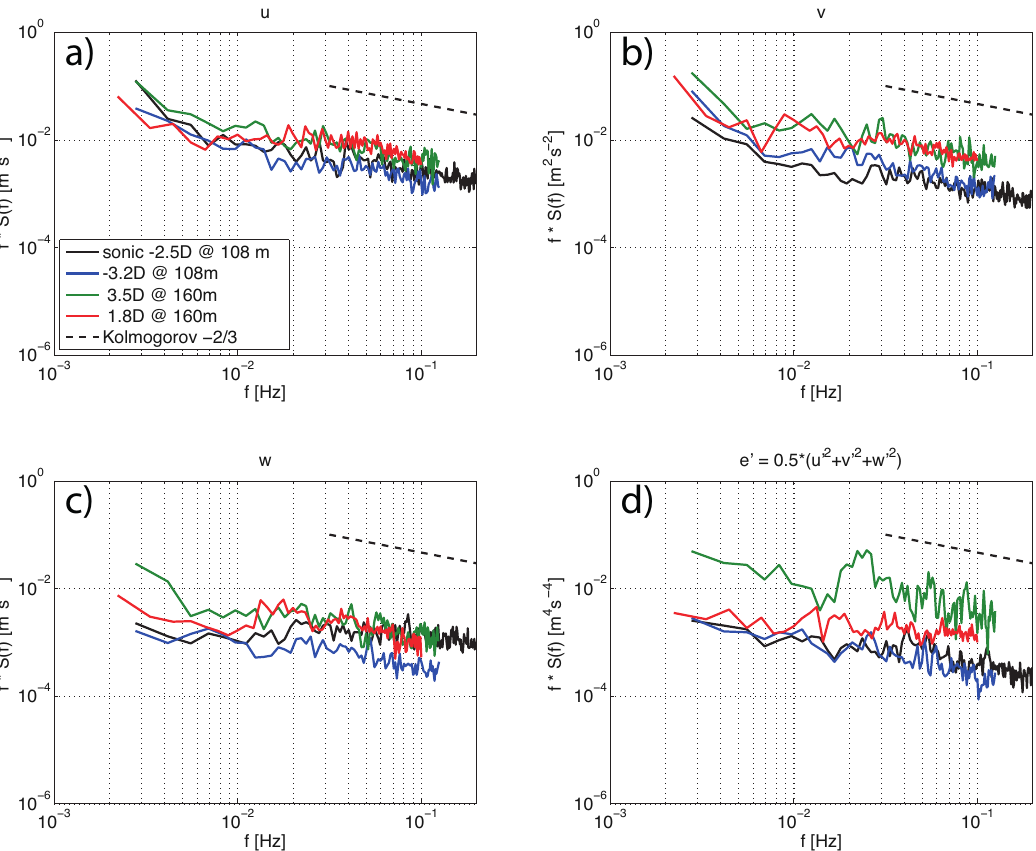
Figure 9. Energy spectra of four hours on 4 March 2014 in free stream (blue and black) and wake conditions (green and red) of the along-wind ( a ), cross-wind ( b ) and vertical component ( c ) u, v, w and TKE ( d ). Black and blue colors show data from the sonic anemometer and Windcube wls67 at 108 m; red and green colors show Windcubes wls37 and wls65 data at 160 m. The dashed line indicates the − 2/3 Kolmogorov